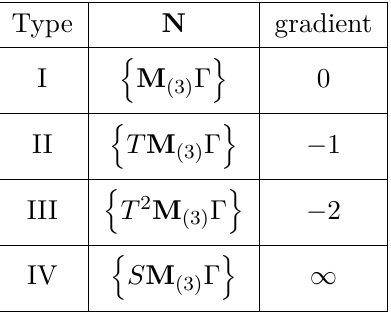
Table 1 . Types for D = 3